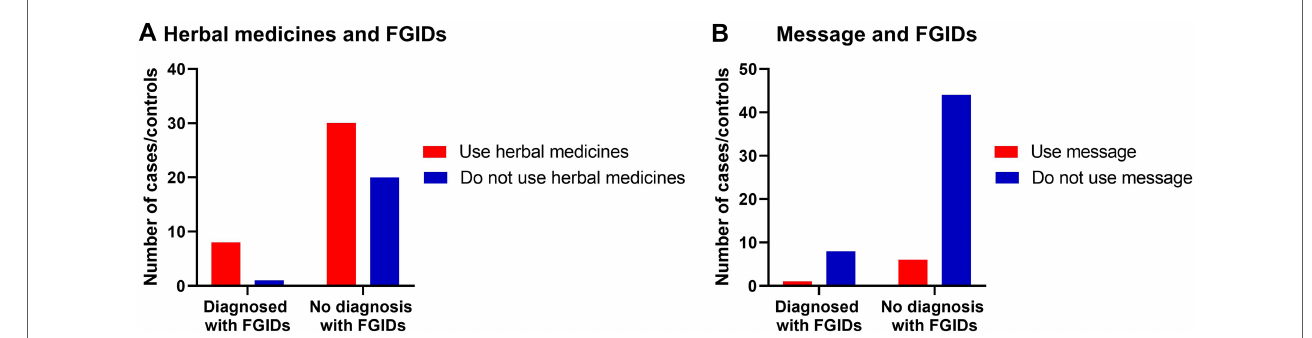
FIGURE 4 The relationship between FGIDs and using herbal medicine and relaxation therapy. Data represent frequency ( n =59) of ( (cid:129) ) cases and ( (cid:129) ) controls of ( A ) using herbal medicine among children with FGIDs, ( B ) using relaxation therapy among children with FGIDs. Chi-square test was used to test the relative risk of using herbal medicine and relaxation therapy among children with FGIDs. Data at which values differed signi fi cantly, * p ≤ 0.05, ** p ≤ 0.01, *** p ≤ 0.001.